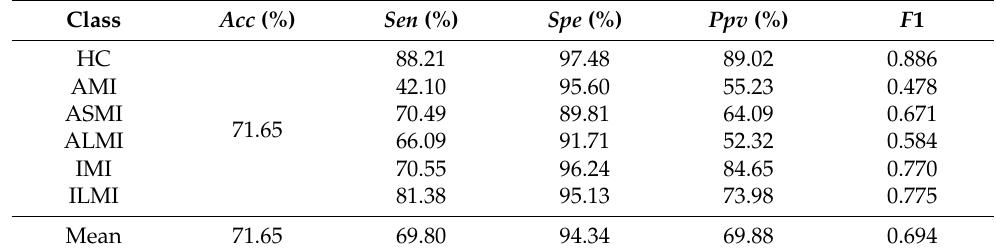
Table 2. The performance of MI localization using a group of binary classifiers on the PTB database.